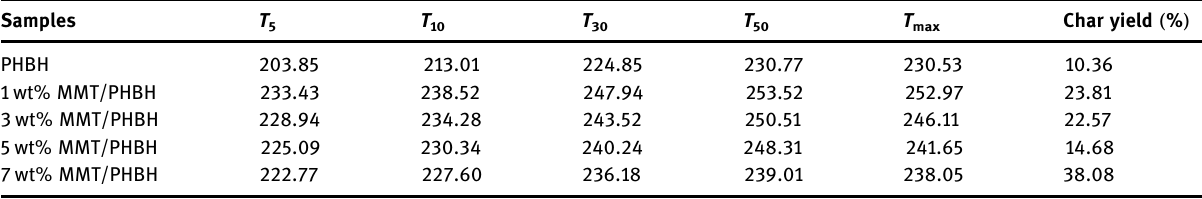
Table 2: The TGA data of PHBH/MMT biocomposites with di ff erent MMT contents Samples